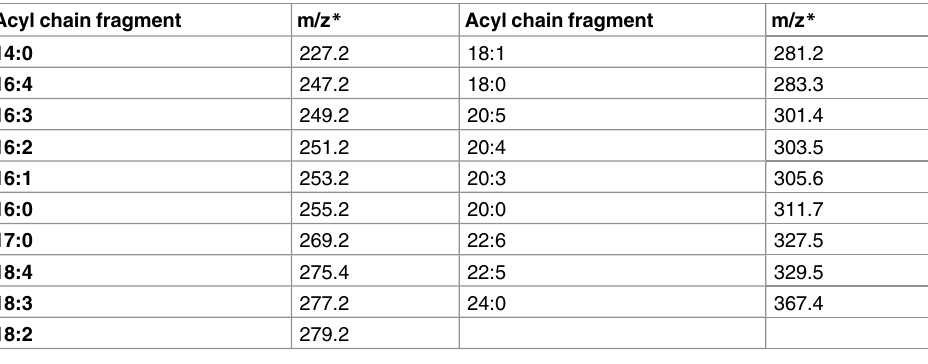
Table 1. Acyl chain fragments for MRM and NL